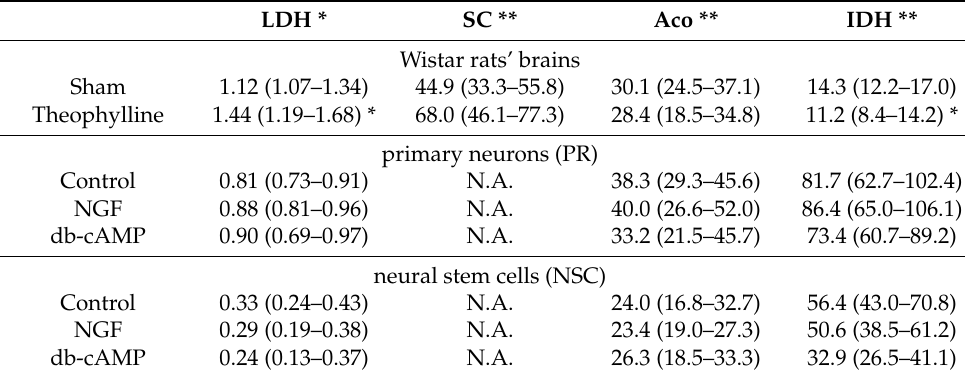
Table 4. Enzymatic profile of research